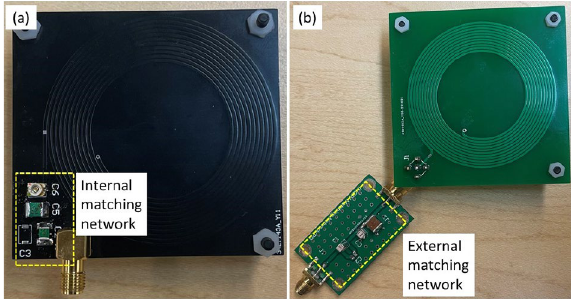
Figure 7. Two versions of the open-geometry detector (a planar coil) were developed: ( a ) with an internal matching network used for fine-grained tuning of the coil; and ( b ) with an option for attaching an external tunable matching